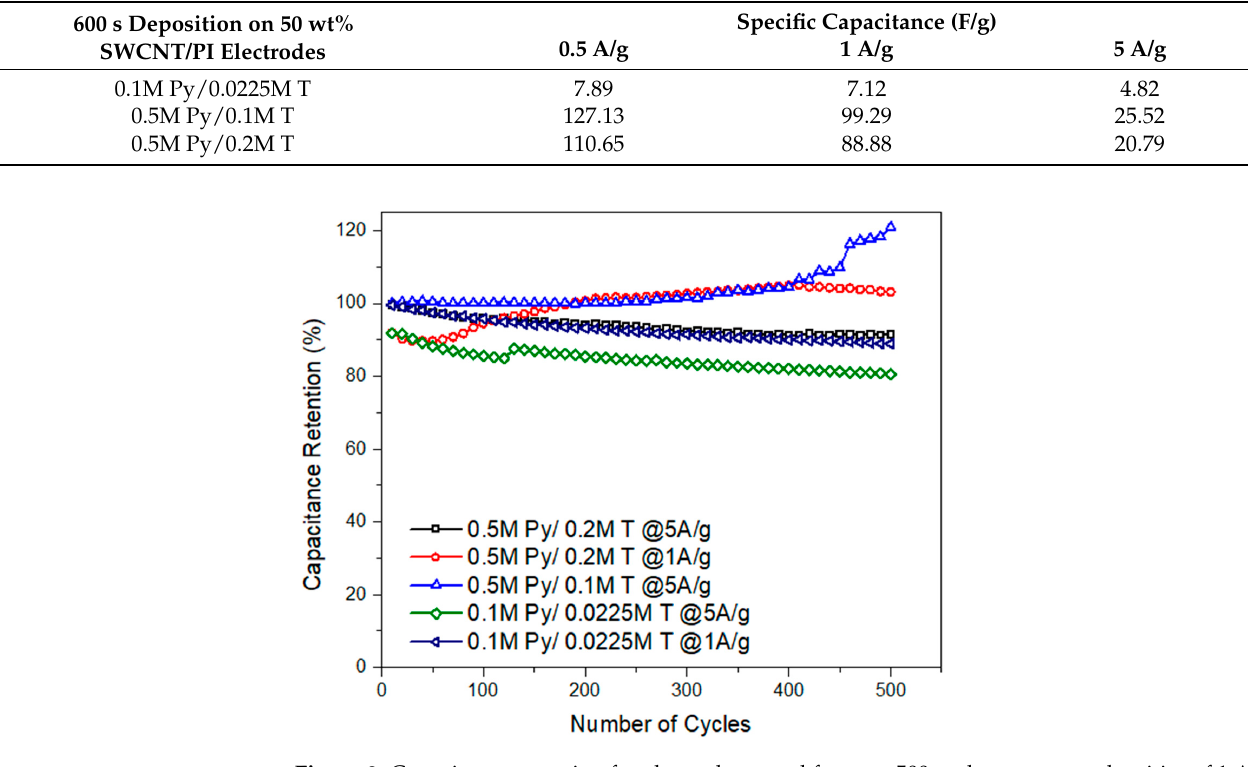
Figure 9. Capacitance retention for electrodes tested for over 500 cycles at current densities of 1 A/g and 5 A/g.